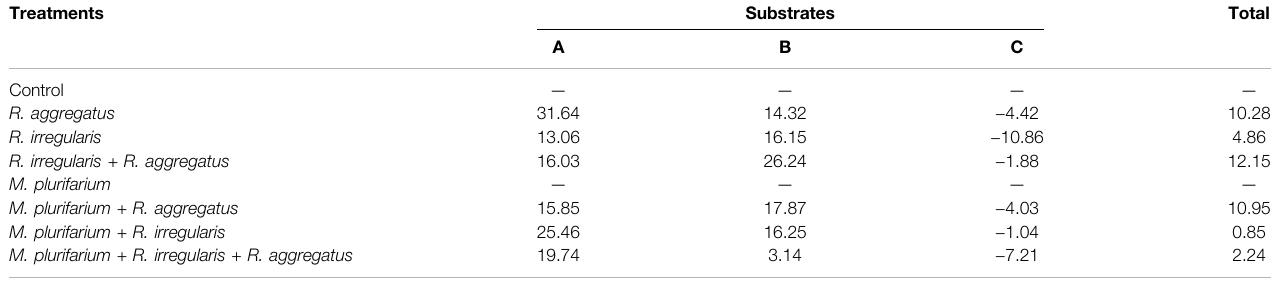
TABLE 4 | Mycorrhizal dependency of S. senegal seedlings as a function of substrate types (A, B, and C). Treatments